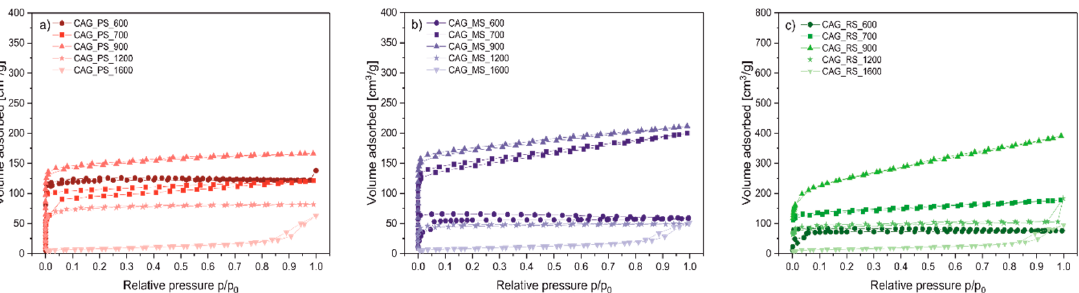
Figure 2. Nitrogen adsorption ‐ desorption isotherms for the samples from ( a ) CAG_PS, ( b ) CAG_MS, and ( c ) CAG_RS series. and ( c ) CAG_RS series.